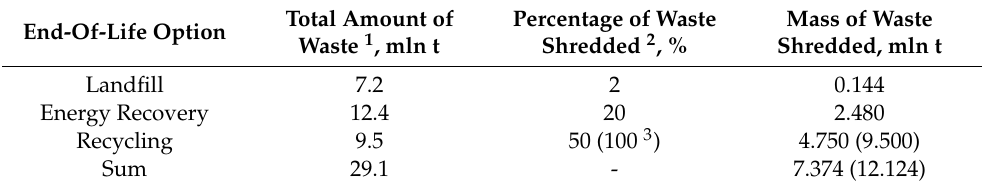
Table 1. Estimated scale of shredding EoL polymer materials in EU countries in 2018. Total Amount of Percentage of Waste End-Of-Life Option Waste 1 , mln t Shredded 2 , % Landfill Energy Recovery 12.4